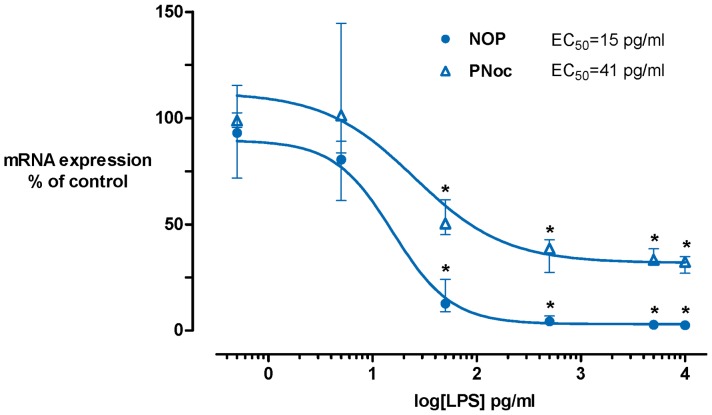
Effects of LPS on NOP and PNoc mRNA expression.Whole blood was cultured without LPS or with increasing concentrations of LPS 0.5–104 pg/ml for 6 hrs. LPS suppressed both NOP and PNoc mRNA expression. Data are presented as medians with interquartile ranges. n = 4, Kruskal-Wallis test with subsequent post hoc analysis, *: p<0.05. LPS, lipopolysaccharide; NOP, nociceptin receptor; PNoc, nociceptin precursor.